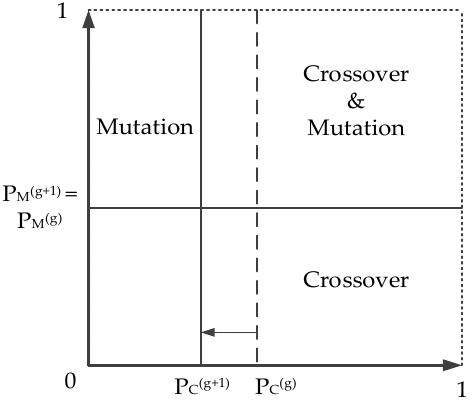
Figure 5. Variation for increasing crossover probability.